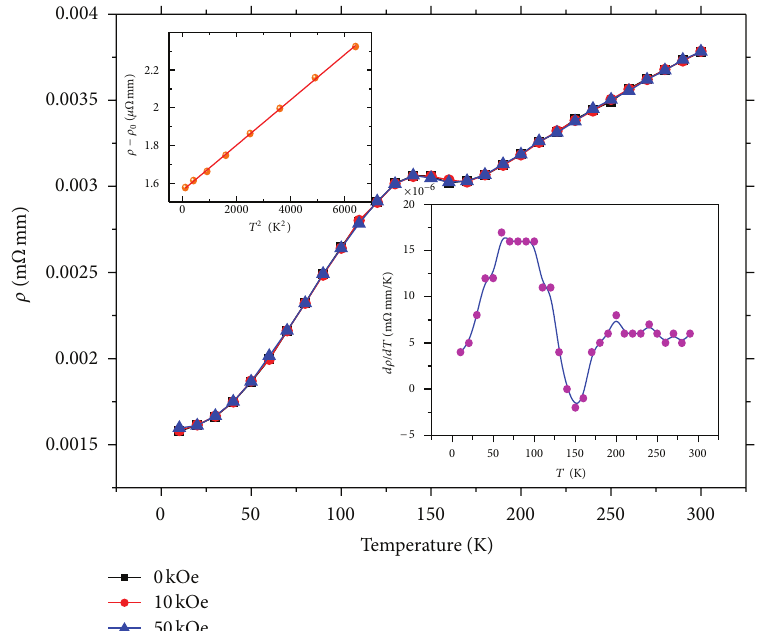
Figure 4: Temperature-dependent resistivity of Mn 3 Zn 0.9 Cu 0.1 N measured at 𝐻 = 0 kOe, 10kOe, and 50kOe. The top inset: linear fitting of 𝑇 2 below 80 K according to (1). The bottom inset: temperature dependence of 𝑑𝜌/𝑑𝑇 𝜌 − 𝜌 0 versus